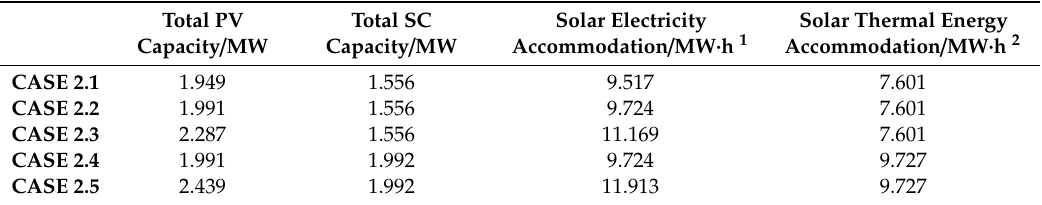
Table 2. Configuration